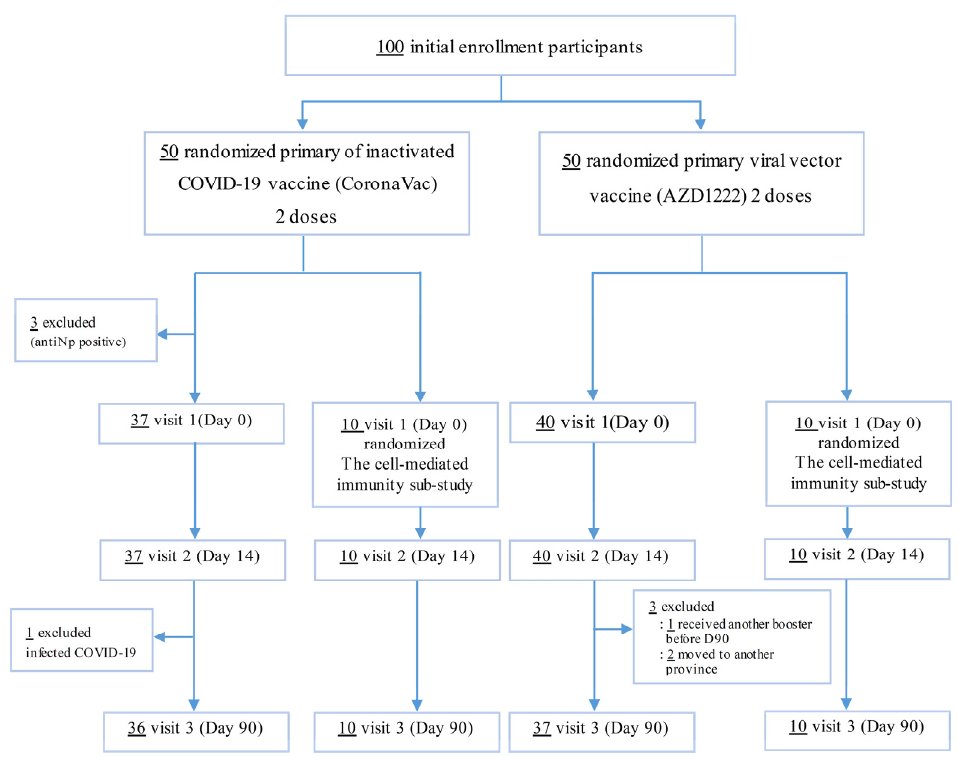
Figure 1. Flow diagram outlining the selection process for inclusion and exclusion of participations in the study.